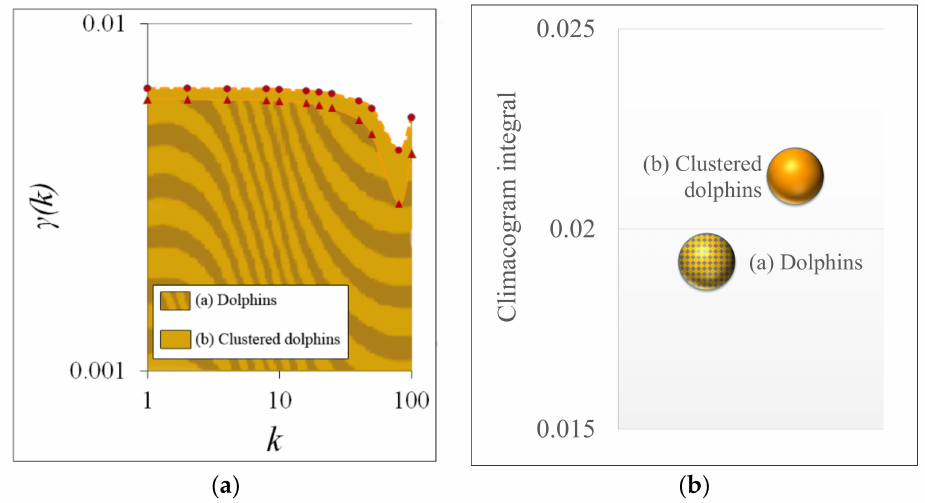
Figure 5. ( a ) Cumulative areas underneath each climacogram for each scale of Figure 4a,b; ( b ) Rate of alteration of clustering of Figure